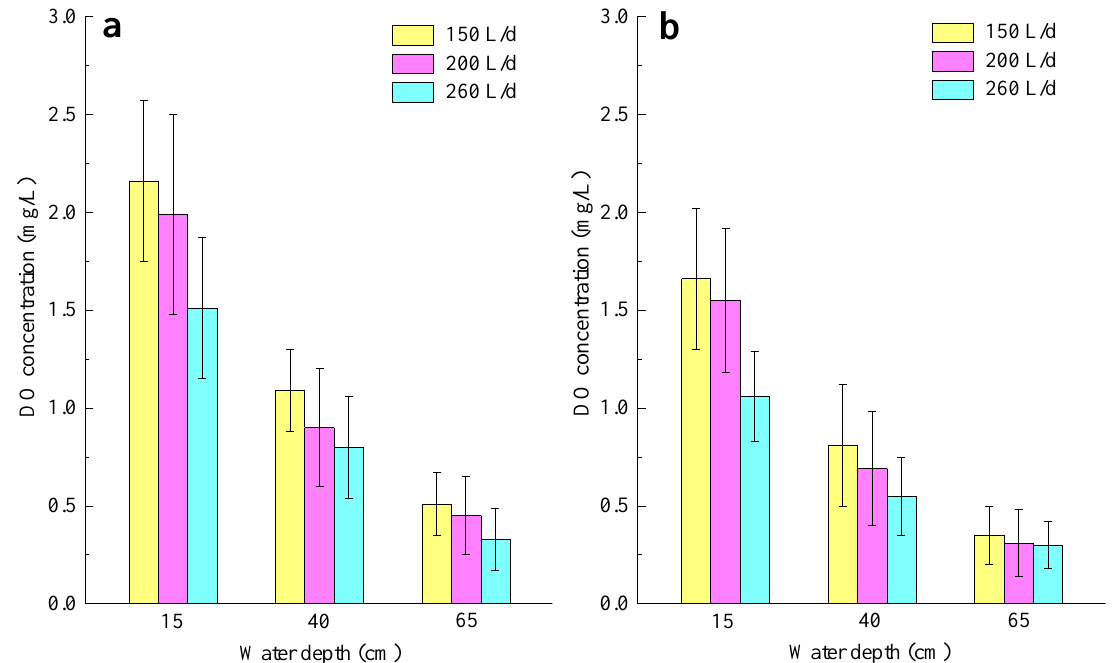
Figure 2. Dissolved oxygen (DO) distributions in the VFCW ( a ) and HFCW ( b ) ecosystems under different influent loads. The results were the averages and their standard deviations.